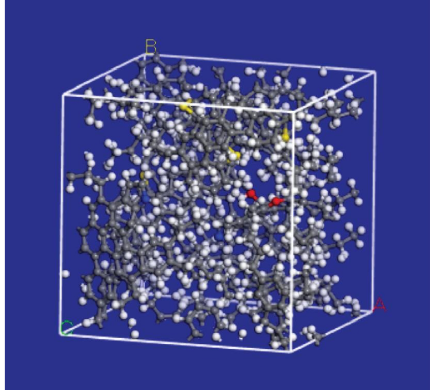
Figure 1: Molecular model of asphalt.